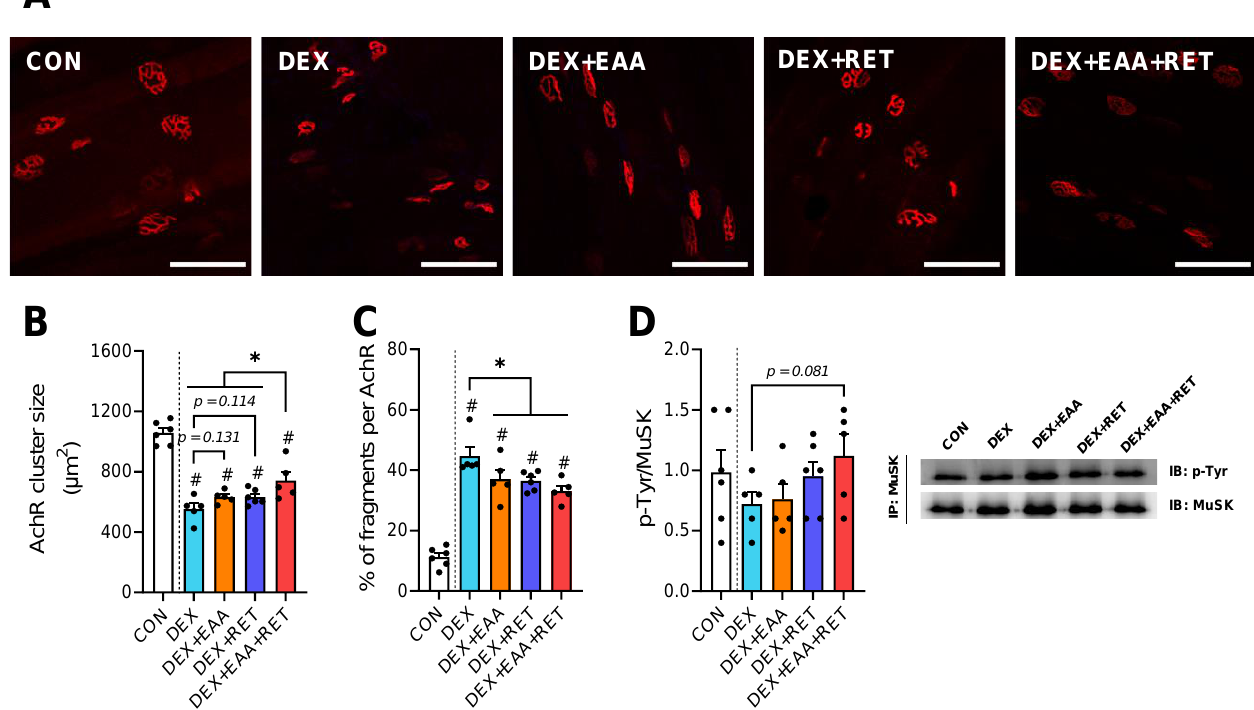
Figure 3. Combined treatment of EAA and RET restores a decrease in NMJ stability in skeletal mus- cle by DEX treatment. ( A ) Representative image of an acetylcholine receptor staining in plantaris. (n = 5 – 6) . Scale bar, 100 μm. ( B ) Acetylcholine receptor cluster size in plantaris (n = 5 – 6). ( C ) Percent- age of fragmented acetylcholine receptor in plantaris (n = 5 – 6). ( D ) Representative image and rela- tive protein expression of Musk (n = 5 – 6). Data are presented as mean ± S.E. # Significant difference from control group ( p < 0.05). * Significant difference between labeled groups ( p < 0.05). CON, sed-